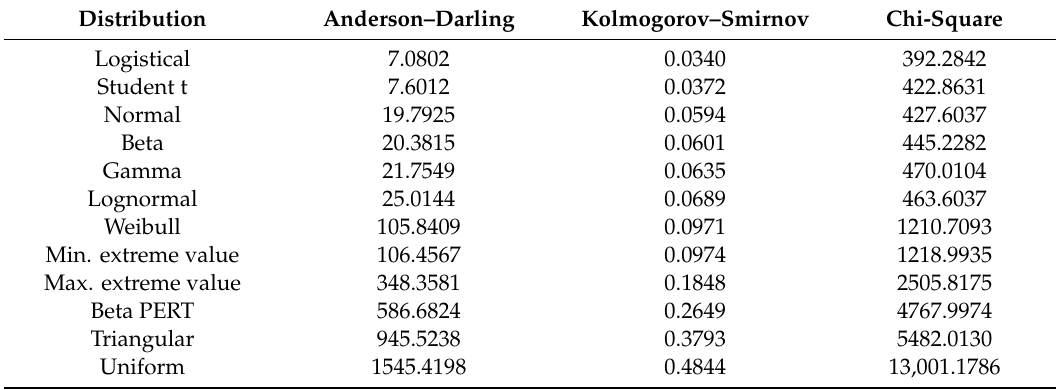
Table 8. Goodness-of-fit test results for EEX peak-power spot prices in 2014. Distribution